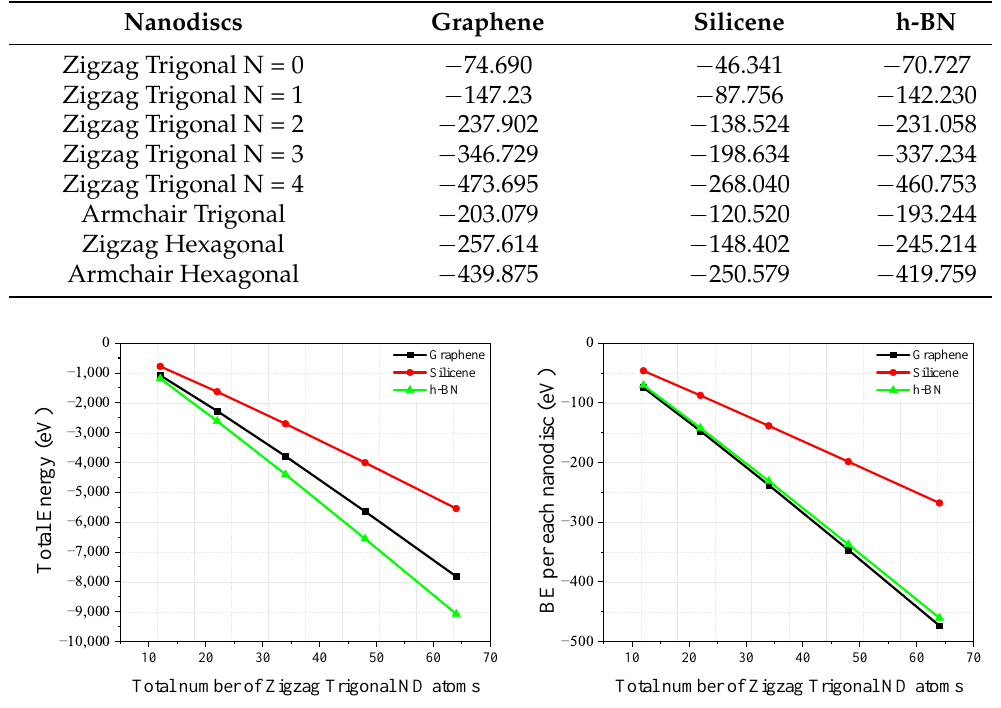
Table 1. The binding energy (in units of eV) for different selected 2D materials.